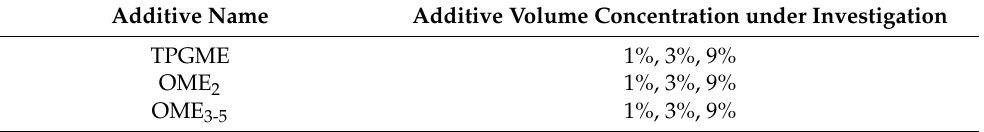
Table 1. Additives and volume concentrations of additives used for all investigations. All additives were mixed with baseline